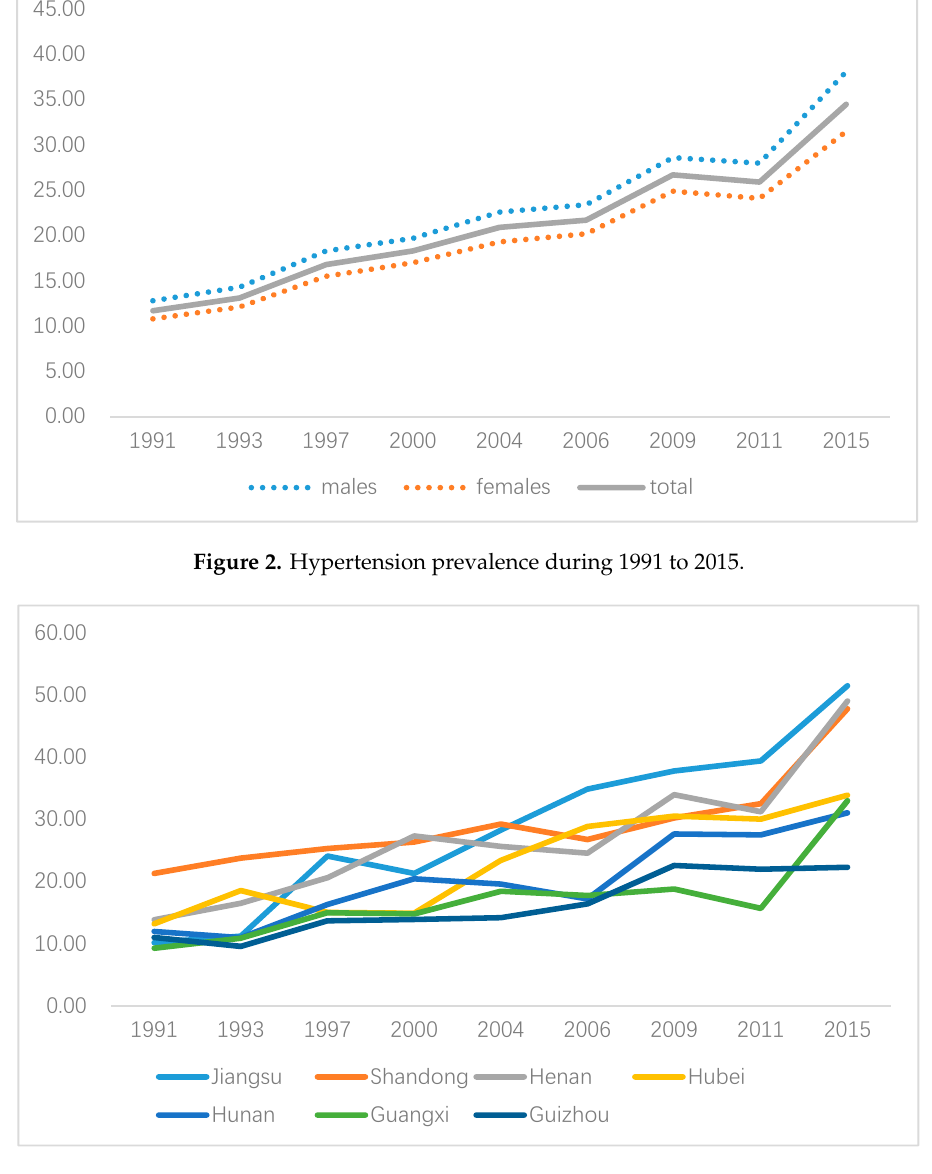
Figure 3. Area-specific hypertension prevalence (male). Table 2. Global cluster for hypertension prevalence by